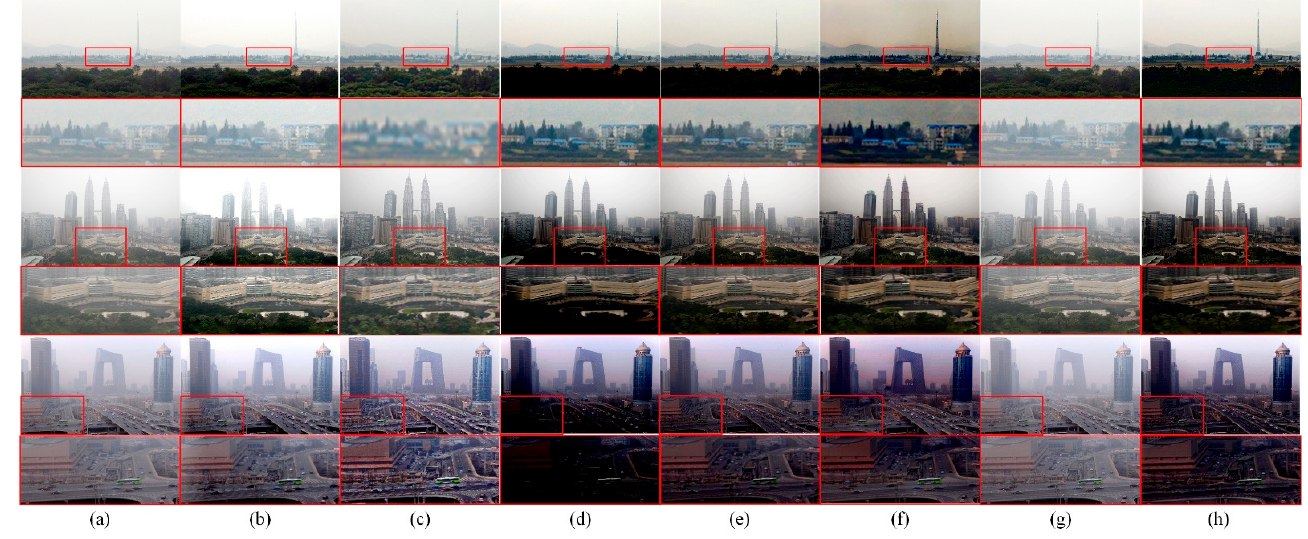
Figure 5. Dehazing results on HSTS dataset. ( a ) Hazy image; ( b ) Fattal’s [26]; ( c ) FVR [43]; ( d ) DehazeNet [32]; ( e ) AOD-Net [15]; ( f ) EPDN [26]; ( g ) AECR-Net [36]; ( h ) TID (ours).